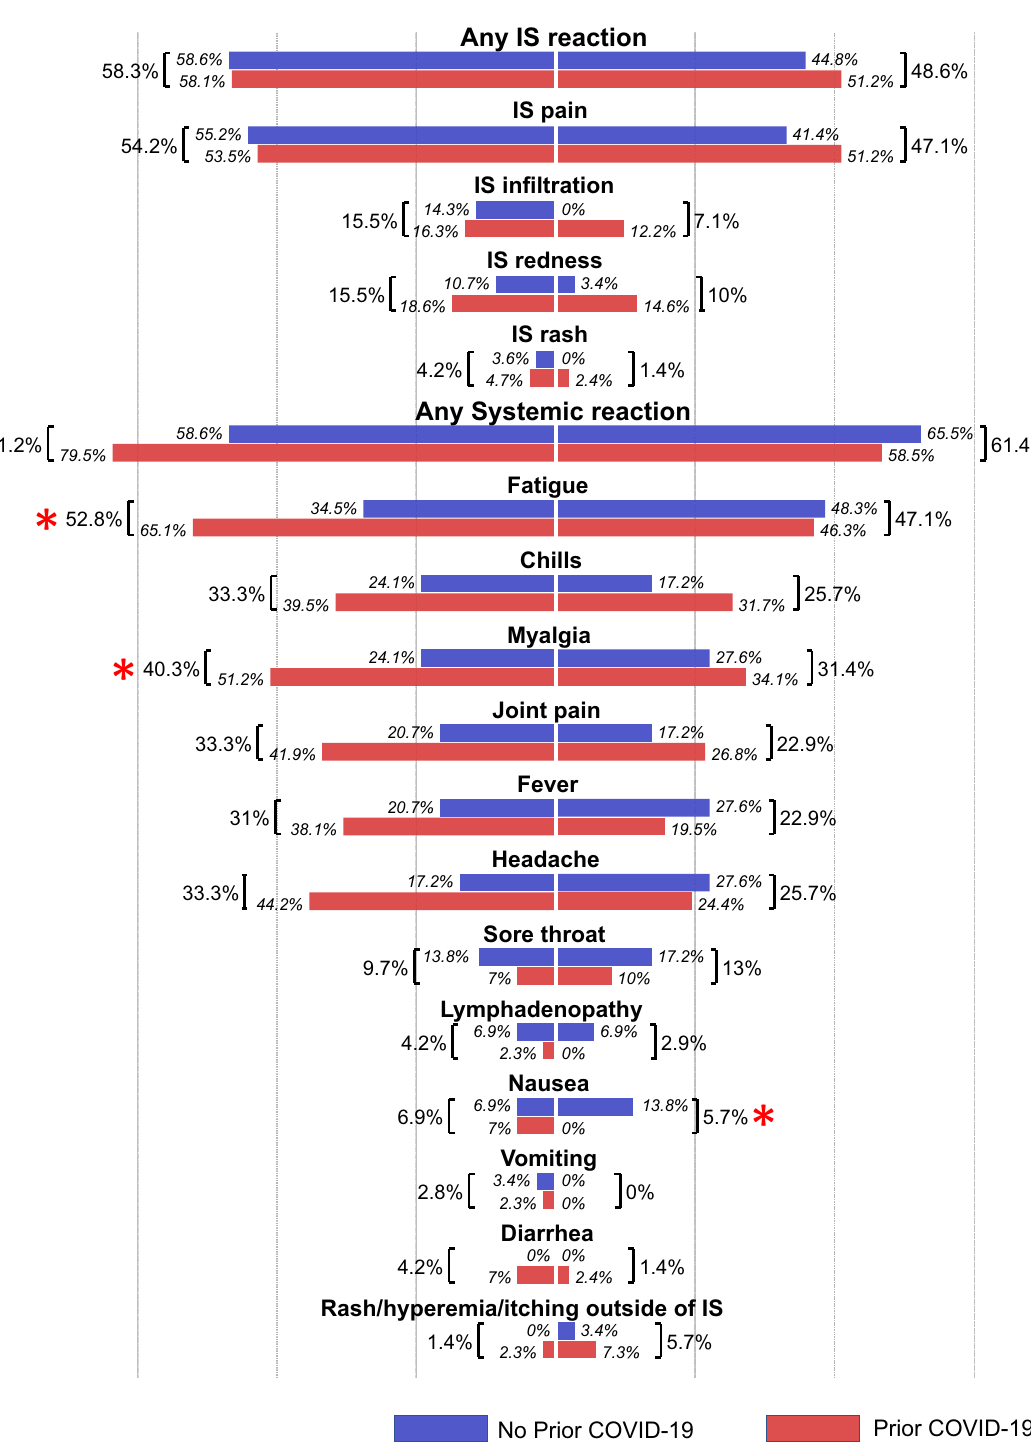
Figure 2. Solicited adverse events (AE) associated with Sputnik-V vaccination. Bars and percentages represent the proportions of participants reporting an AE. Stars represent significant differences ( p < 0.05) in AE presentation between the Prior and No Prior COVID groups. IS injection